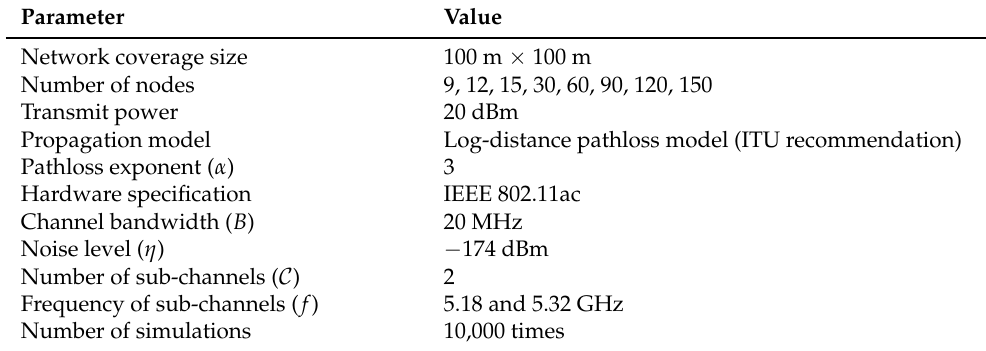
Table 1. Simulation parameters and